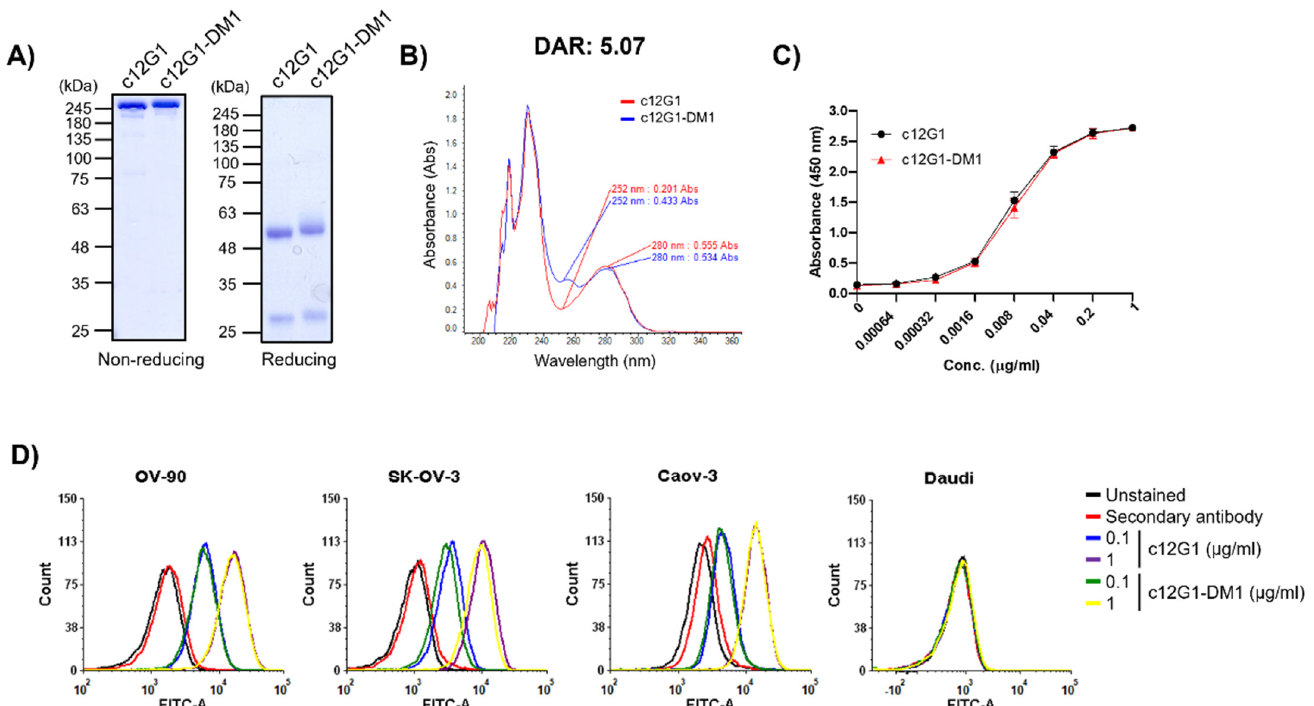
Figure 3. The c12G1 antibody is internalized into ovarian cancer cells. ( A ) Ovarian cancer cells were incubated in the presence or absence of c12G1 (1 µg/mL) at 4 °C or 37 °C, for 1–3 h, and then subjected to flow cytometer analysis. The fluorescence signal of the c12G1-nectin-2 complex on the cell surface decreased after incubation at 37 °C. ( B ) OV-90, SK-OV-3, or Caov-3 cells were treated with the c12G1/Zenon™-conjugated anti-Fc FAB complex for 15 h, following which the Zenon™- positive cells were analyzed using FACS (* and ***, vs. control). All experiments were independently repeated at least three times. * p < 0.05, *** p < 0.0001.